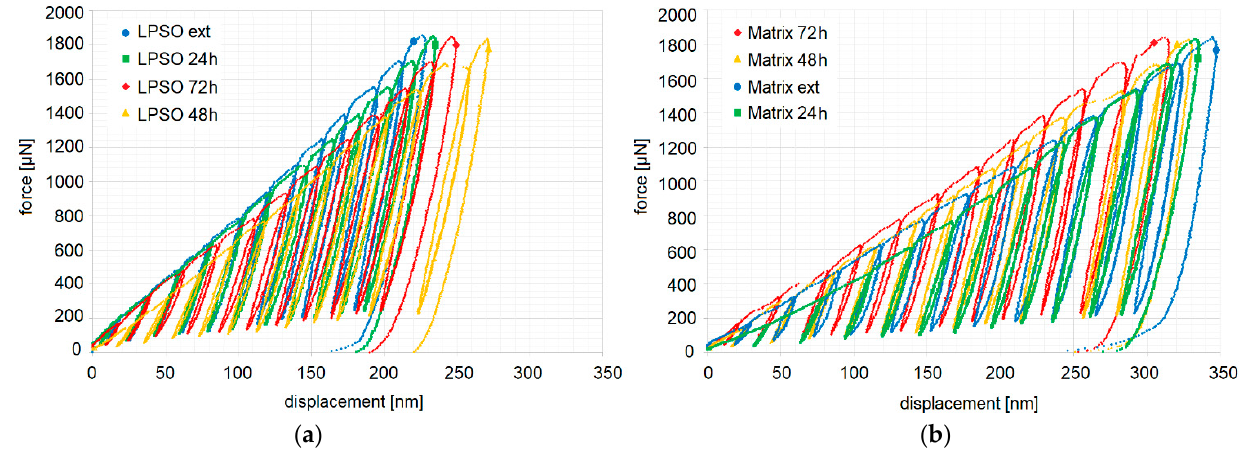
Figure 13. Representative force ‐ displacement curves of multi ‐ cycle indents up to 2 mN in Mg ‐ Dy ‐ Nd ‐ Zn ‐ Zr alloy in the as ‐ extruded and the solution heat ‐ treated conditions at 500 °C for 24 h, 48 h and 72 h: in the blocky LPSO phases ( a ) and in the matrix without LPSO lamellae ( b ).